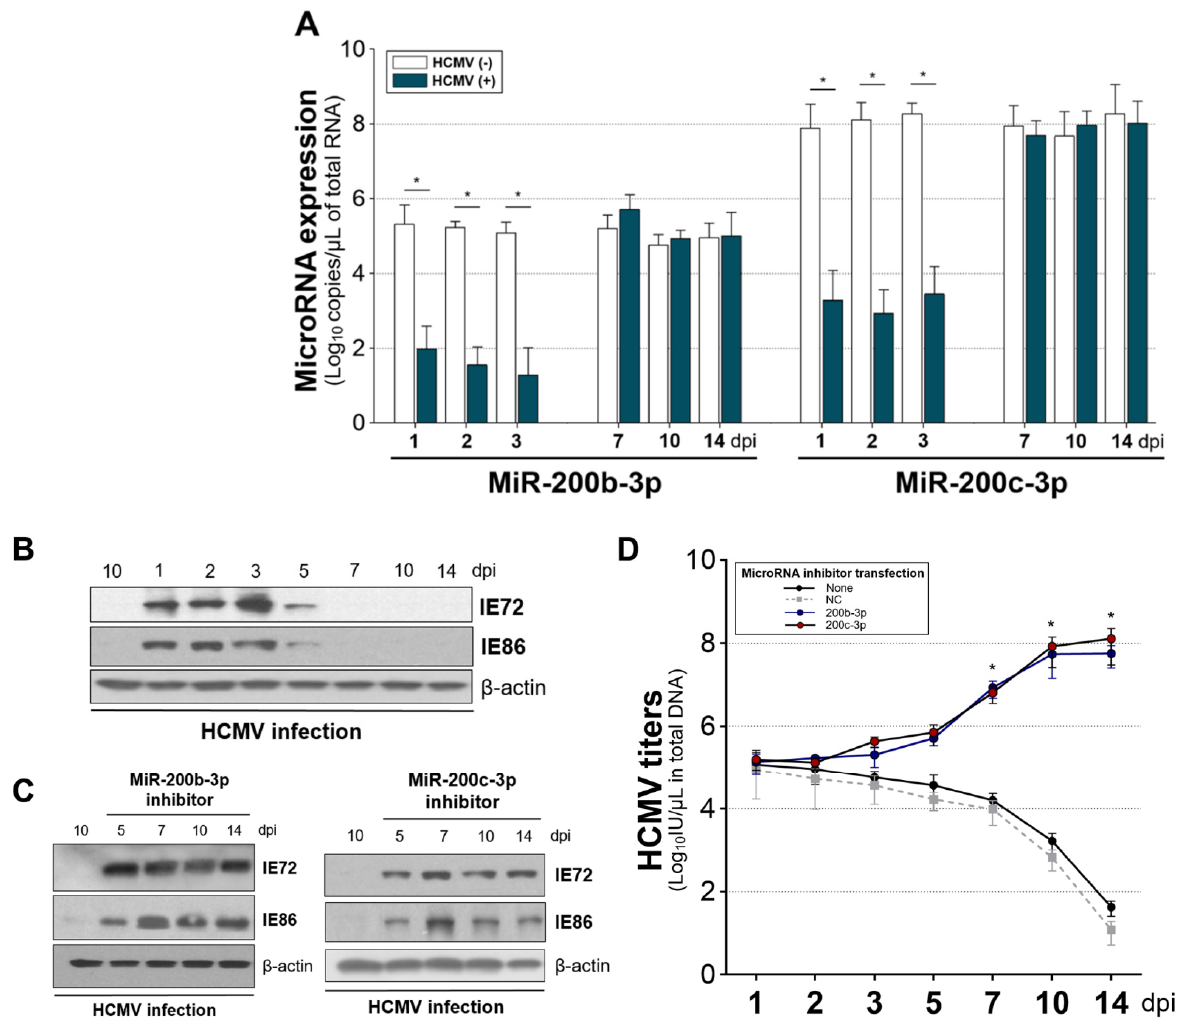
Figure 5. Deliberate downregulation of miR-200b-3p and miR-200c-3p during quiescent latency can induce IE72 and IE86 expression and HCMV replication.THP-1 cells infected with the HCMV Toledo strain at an MOI of 5 were cultured for 14 dpi and were harvested at the indicated dpi. ( A ) miR-200b-3p and miR-200c-3p expression measured by quantitative real-time PCR (triplicate measurements in three separate experiments daily). Levels of IE72 and IE86 protein were measured by immunoblotting HCMV-infected cells in the absence of miRNA mimic or inhibitor transfection ( B ) or with miR-200b-3p or miR-200c-3p inhibitors ( C , left and right panels, respectively). ( D ) Titers of HCMV measured by real-time PCR using UL83 primers. Quantitative results ( A , B ) of triplicate measurements in three separate experiments per dpi ( n = 9) are shown as one box or one dot. Upper lines in the box or dots and error bars indicate means and SEM, respectively. * p < 0.001 vs. miRNA or HCMV DNA copies in cells without HCMV infection ( A ) and in NC mimic-transfected cells ( D